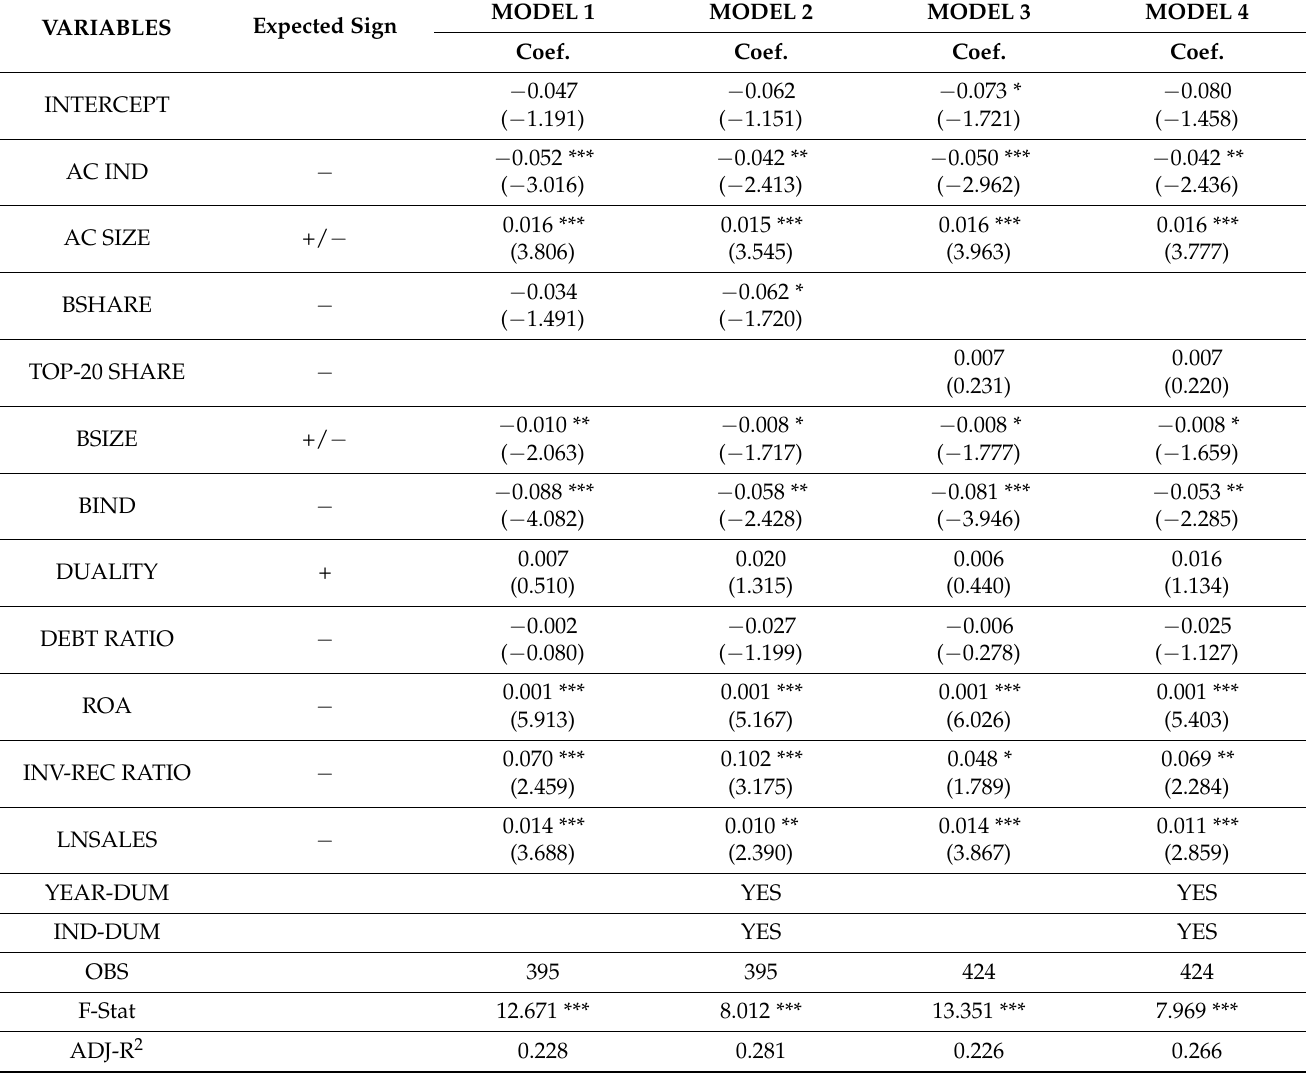
Table 6. OLS regression results (Agency Costs: FCF *